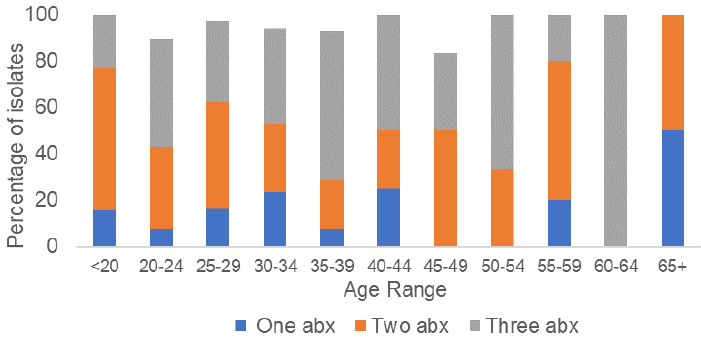
Figure 3. Distribution by age group of NG isolates with resistance or intermediate resistance to multiple antimicrobials. Abx: antimicrobial(s).